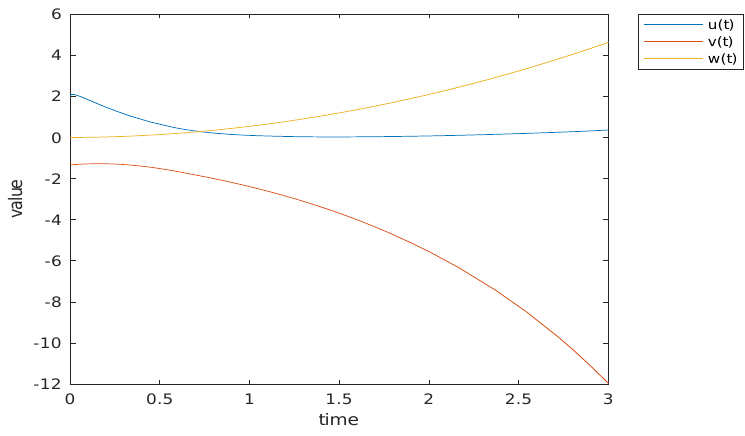
Figure 3. Simulation of solutions in Example